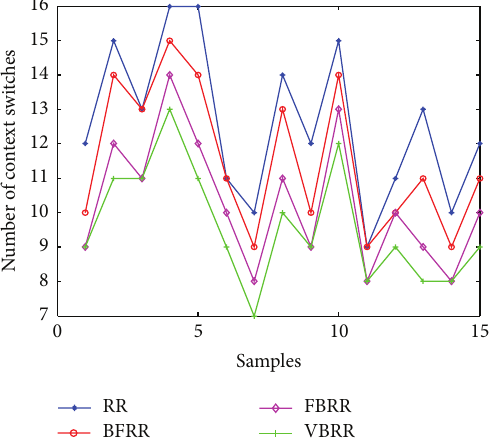
Figure 15: Number of context